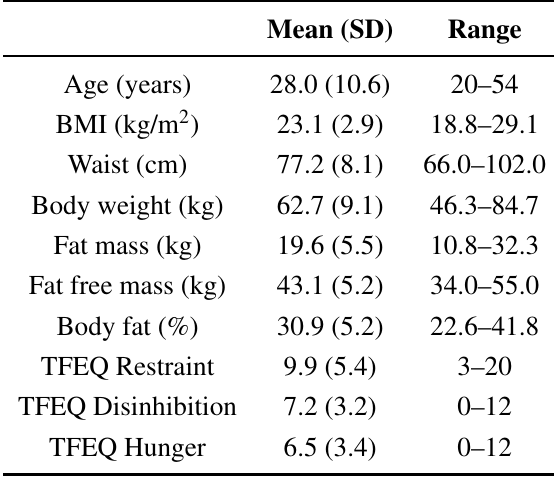
Table 2. Mean (standard deviation) and range for age, anthropometrics, body composition and psychometric trait characteristics for the overall